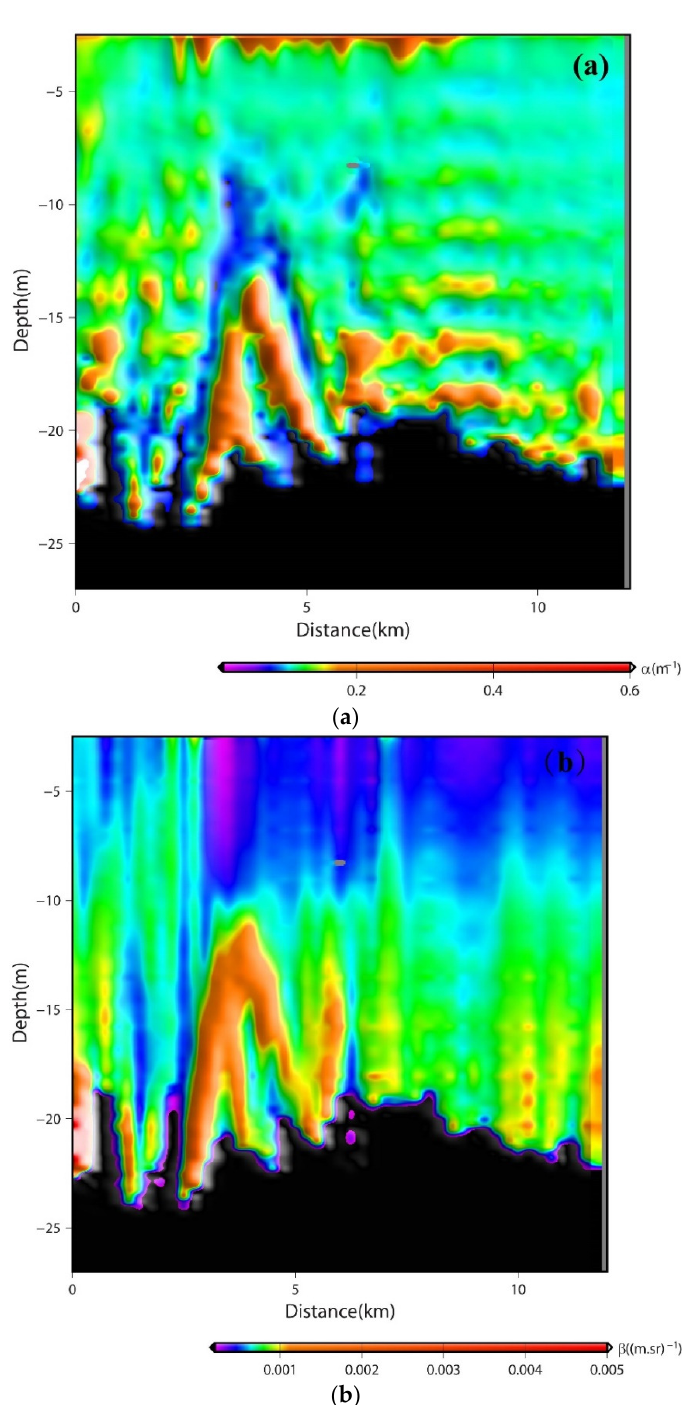
Figure 6. LiDAR-retrieved attenuation and backscattering vertical structure distribution. α ranges from purple (=0.0 m − 1 ) to red (=0.6 m − 1 ). β ranges from purple (=0.0001 (m.sr) − 1 ) to red (=0.005 (m.sr) − 1 ).